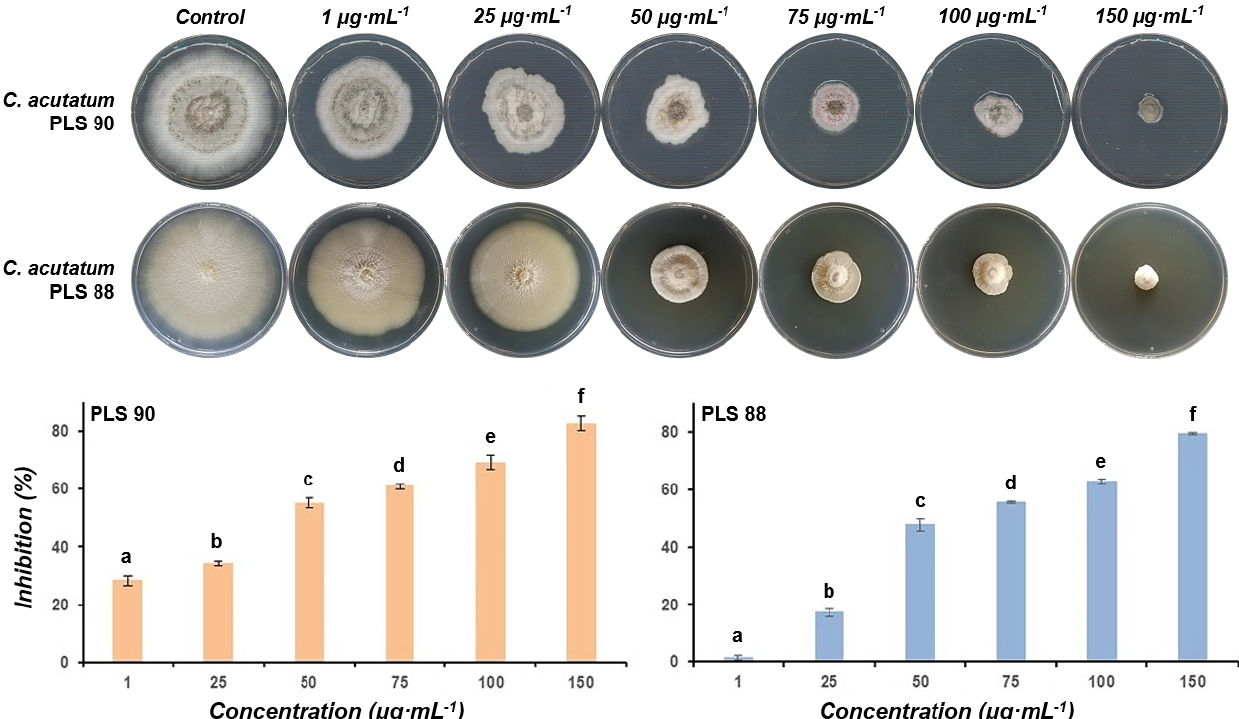
Figure 5. Effect of the total lipopeptide extract of Bacillus sp. PTA13 on the radial growth of cultures of the olive tree pathogenic Colletotrichum acutatum species complex PLS 90 (wild type) and PLS 88 (resistant to PPPs) isolates. Images of inhibition and observations were taken 17 days post-treatment with N = 3 biological replications. The letters (a–f) above the columns indicate statistical differences between the treatments for each isolate, performing the Tukey HSD test ( p > 95%).